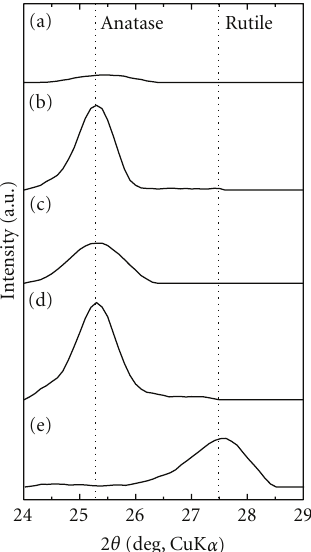
Figure 2: The XRD patterns of the surface coatings on samples treated by (a) AZ treatment up to 100 V in 0.1M H 3 PO 4 aq., (b) AZ-TO treatment (anodized in H 3 PO 4 aq.), (c) AZ treatment up to 80V in 0.1 M NaOH aq., (d) AZ-TO treatment (anodized in NaOH aq.), and (e) TO